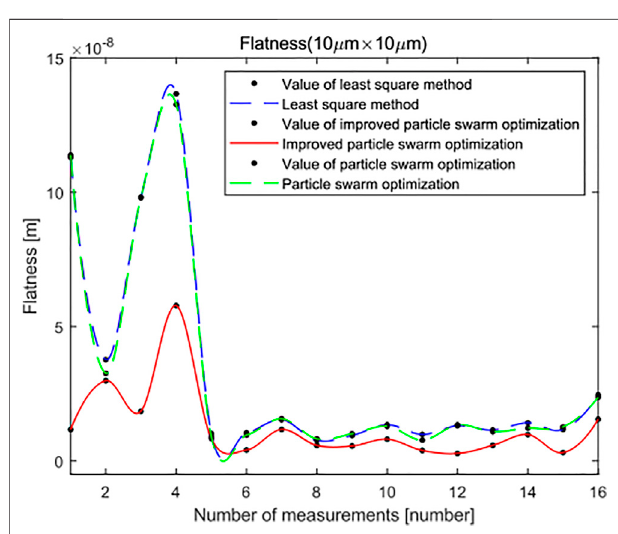
FIGURE18| FlatnesserrorevaluationoftheSHSsampleof10 × 10 μ m.